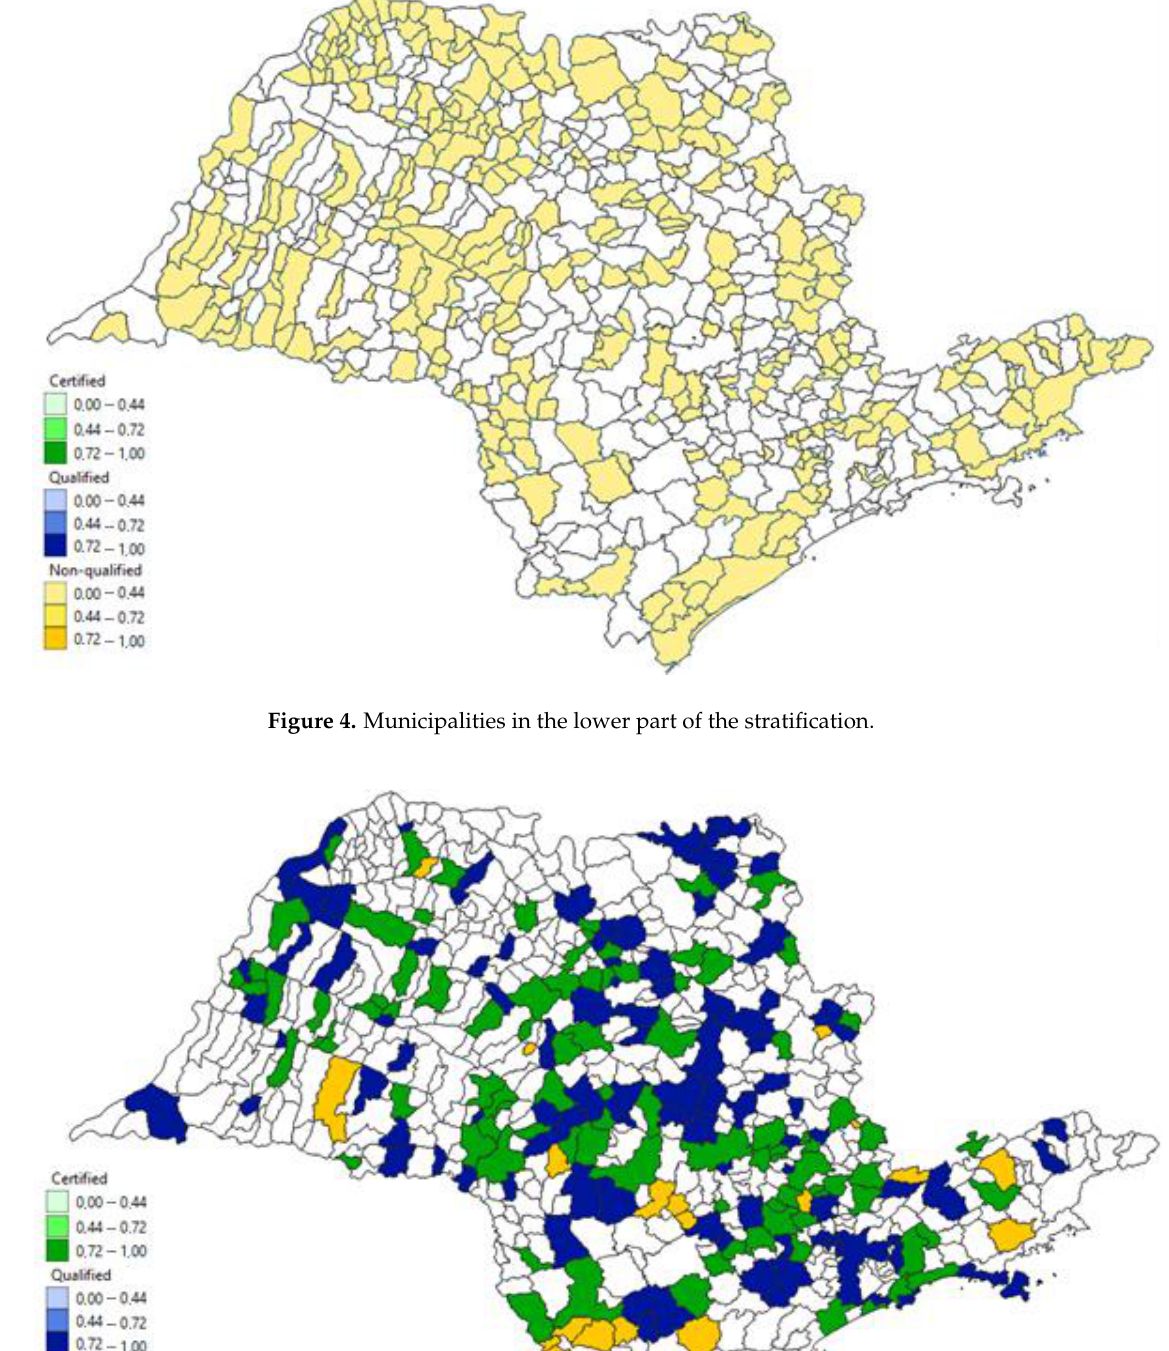
Figure 6. Municipalities in the intermediate range of the Sustainable Human Development Index. In this way, all the certified municipalities present results in the highest level of the index, while the qualified municipalities are located in the intermediate and high levels,